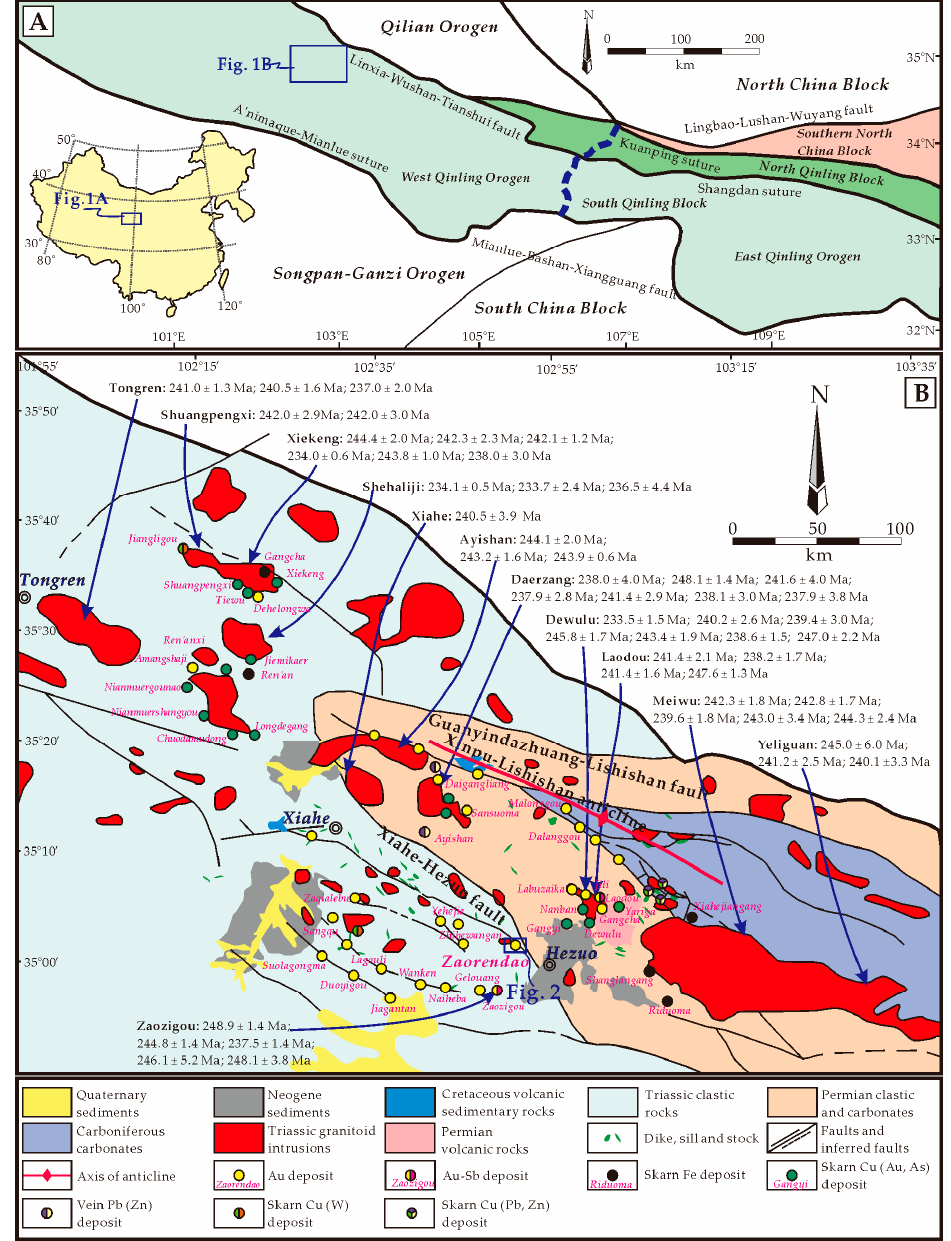
Figure 1. ( A ) Major tectonic domains of China and the location of the Qinling Orogenic Belt. Inset shows the location of the study area (modified after [12]). ( B ) Simplified geological map of the Tongren-Xiahe-Hezuo district of the West Qinling orogen, showing distributions and ages of Early Triassic granitoids and ore deposits (modified after [12] and [21]).